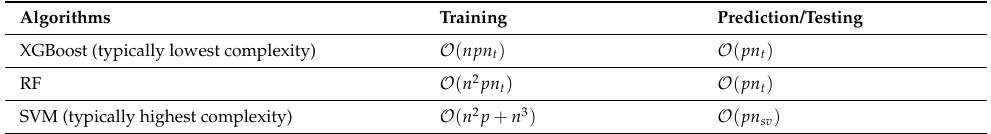
Table 10. Complexity of the considered ML